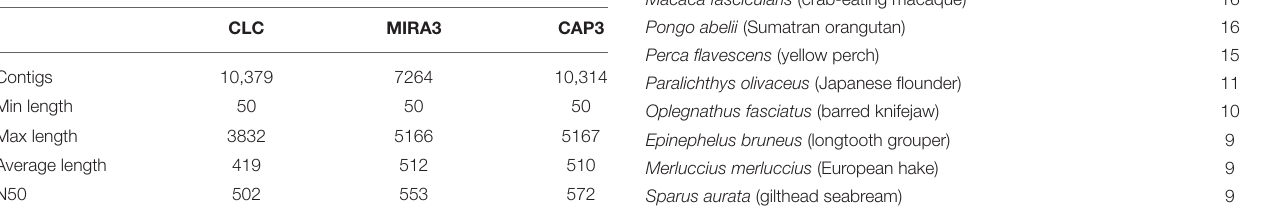
TABLE 2 | Summary of the assemblies done with CLC, MIRA3, and CAP3.